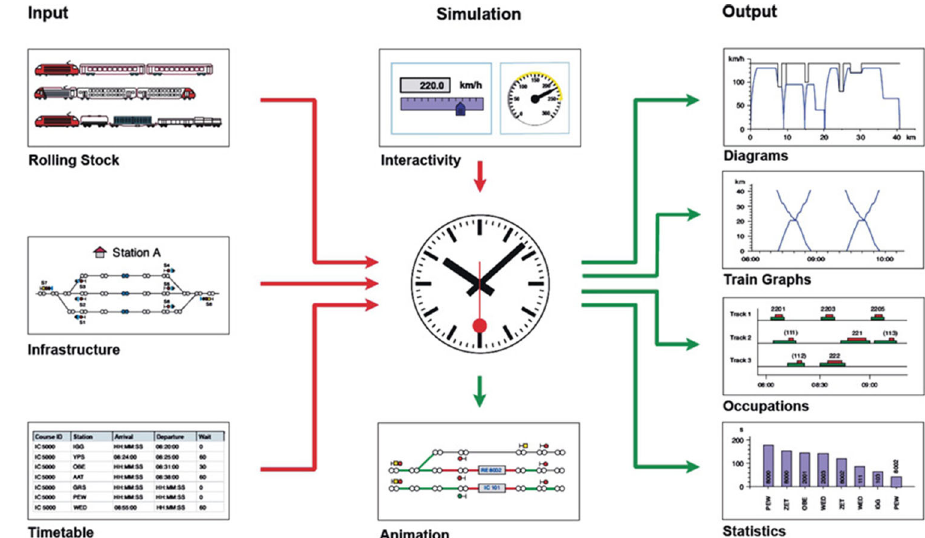
Fig. 6 RailSys architecture [5] Fig. 7 OpenTrack structure